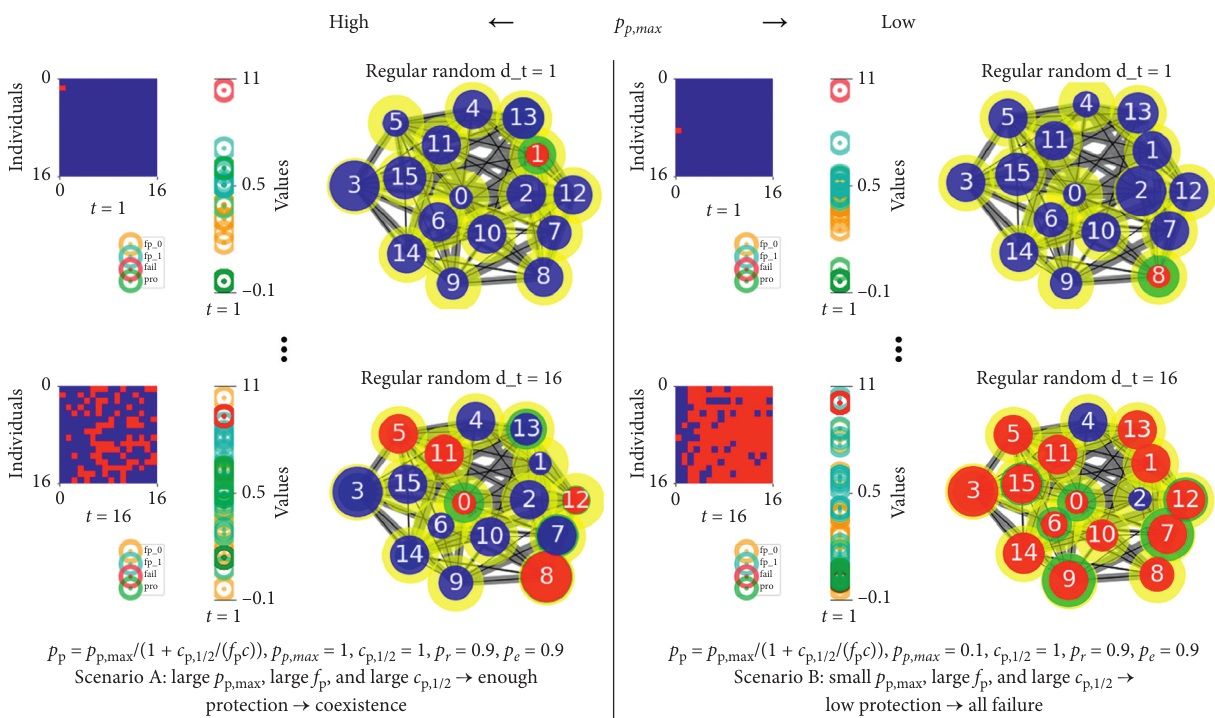
Figure 17: Protection dynamics against systemic risk. In each section, the plot on the left-hand side shows a matrix (horizontal axis � time step from 1 to 16; vertical axis � individuals [16]; color of the matrix � failure state: failure [red] and absence of failure [blue]). The plot in the middle shows each individual’s parameter values at a given time step ( t � 16: orange: fp_0 � strategy [1]; cyan: fp_1 � strategy [2]; red: fail � failure; green: pro � protection potential [ p p ]). The plot on the right-hand side represents individuals’ dynamics within a random network; node number � random label for each node, line width � eigenvector centrality, and node color � states (failure [red] ←⟶ [blue] absence of failure; green � protection potential; yellow � initial structure of the state without failure and protection). The initialized pa- rameters of the simulations are as follows: nodes n � 10, connection d � 0.9 (% � 5.5), p p,max � 1, f p σ � 0.1, p n � 0.1, p l � 0.3, and t � 10 (see Appendixes 1 and 2 for the results of the entire